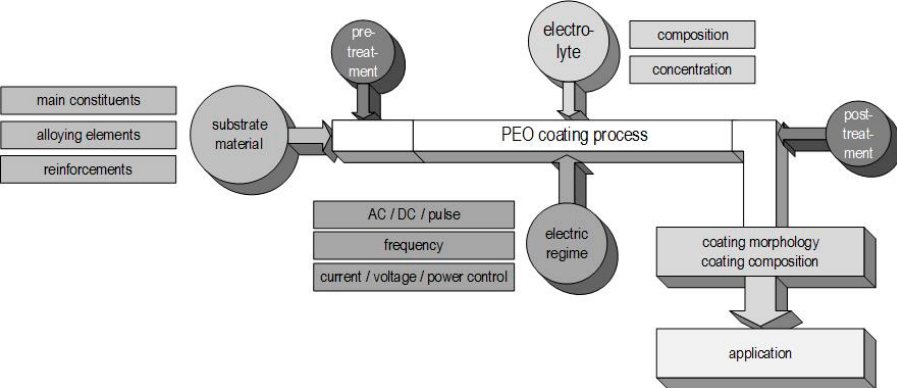
Figure 3. Schematic graphic representation of the PEO process and its dependencies from the uncoated substrate over the process parameters to the application.